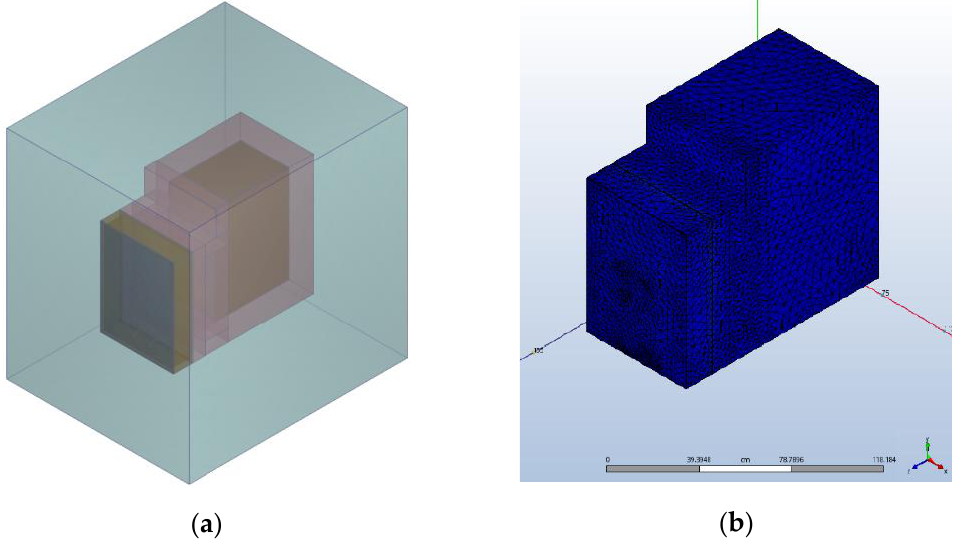
Figure 10. The global system imported in the simulation environment: ( a ) the global system inside the air volume; ( b ) meshing of the global system.